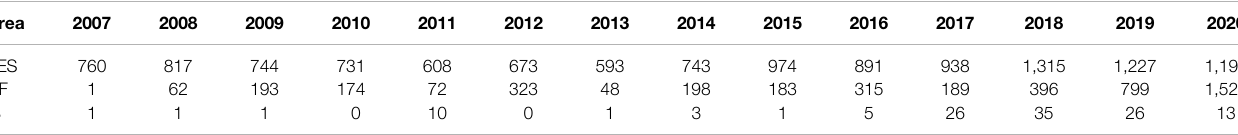
TABLE 2 | Earthquakes per year in Vesuvius, Campi Flegrei and Ischia volcanoes in 2007 –